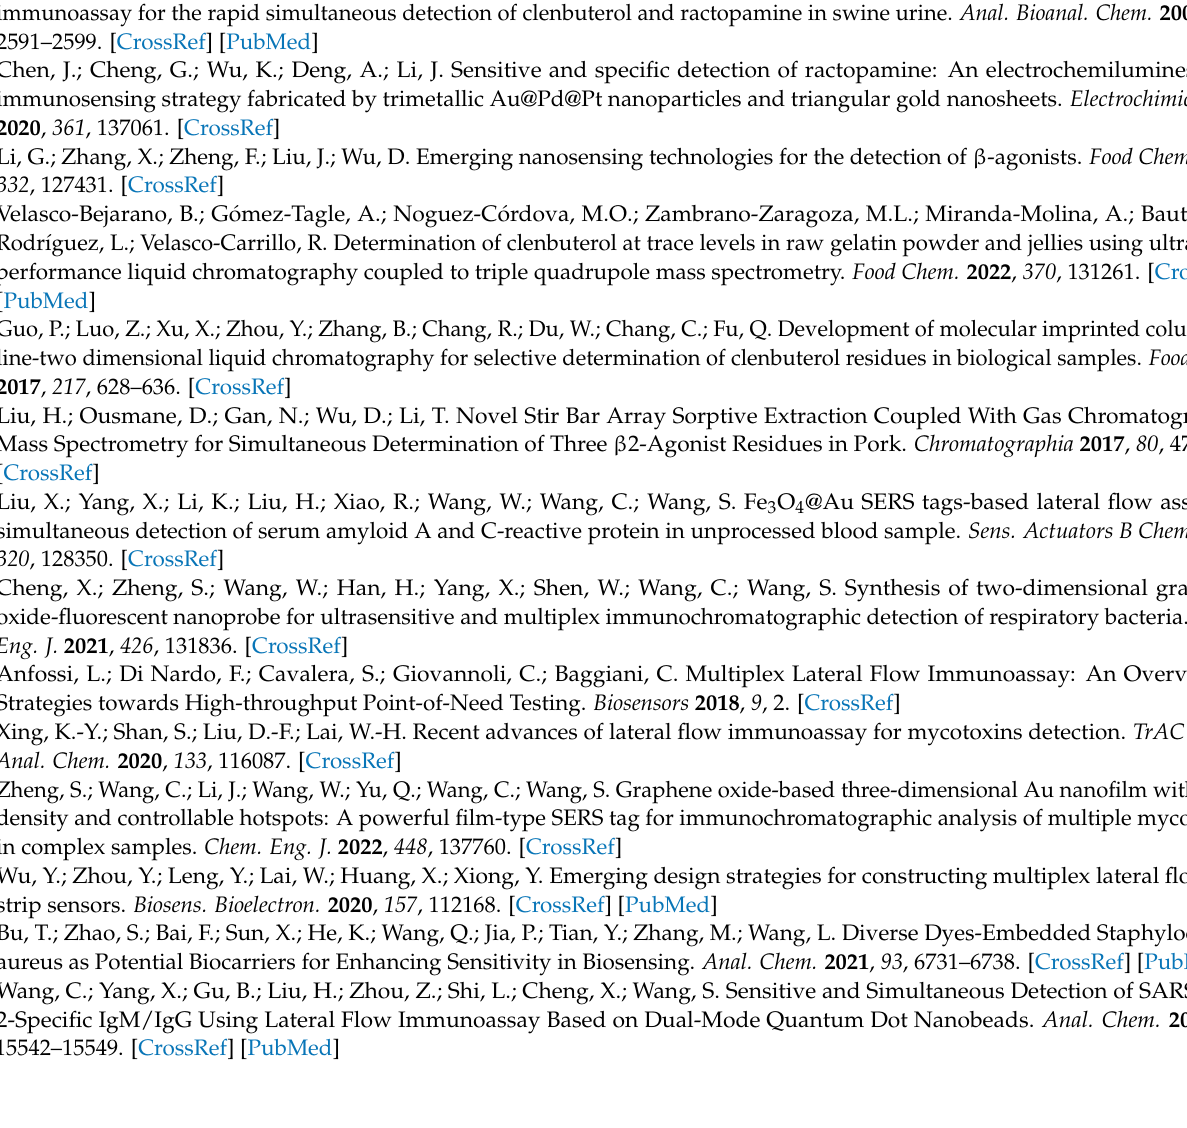
Table S1: the recoveries of CLE and RAC in actual food samples detected by the established